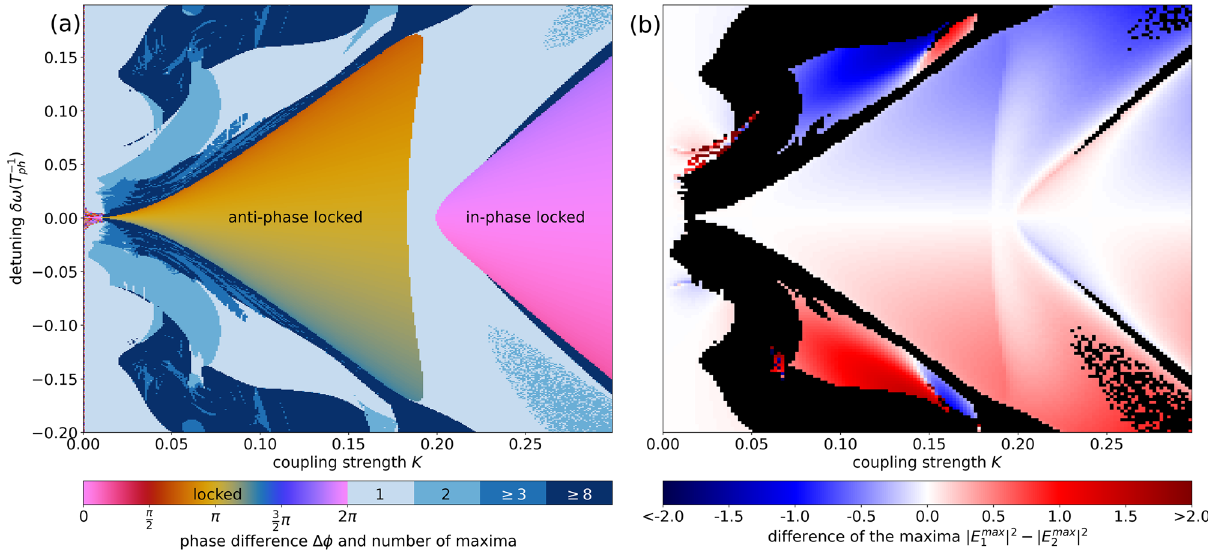
Figure 5. Dynamics in ( K , δω) -space. ( a ) The number of maxima of time series | E 1 ( t ) | 2 is shown in blue. The second color map encodes the phase difference �φ between the electric fields of the two lasers when they are phase locked on a CLM. ( b ) Intensity difference between both lasers ( | E max 1 | 2 − | E max 2 | 2 ) color coded in blue and red, white indicates identical laser emission. Areas with more than one maximum are masked black. Other parameters are T 2 = 1 , �ω = 3 , p = 2 , θ = 0 , τ = 10 , T = 392 -dependent deformations of the curves, every row shows a similar trend: For non-zero detunings, the pitchfork bifurcations, where the constant-phase and symmetry-broken CLMs coincide, are destroyed and we observe an anti-crossing instead. The CLM branches link and form horseshoe formed closed curves. This happens for both lasers (laser 2 printed transparent). For the laser emission this means that both lasers now always emit at differ- ent intensities at the CLM solutions. Thus, due to the symmetry breaking induced by δω (non-identical lasers) we loose the clear distinction between constant-phase and symmetry-broken solutions. The side of opening and closing of the horseshoe is opposed to each other for both lasers. The deformed horseshoe-curves include stable CLMs, marked by black surrounding. The curves shrink, which indicates that the lasers can not stabilize for arbitrarily large detunings. When increasing the detuning δω we observe (not shown) that the horseshoe-formed curves pull together onto one point until they vanish completely and locking becomes impossible. As mentioned before, the CLM solutions plotted in Fig. 4 are obtained by continuously tuning the coupling phase θ . For the specific choice of θ = 0 , the CLMs are marked by white and black dots. By inspecting those dots